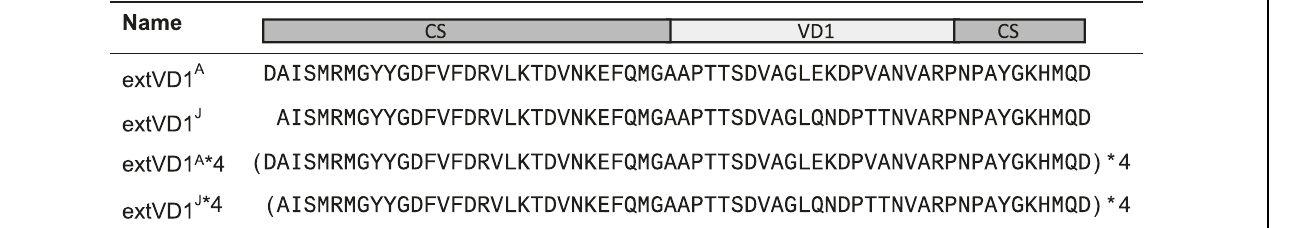
CS conserved segments, VD1 variable domain